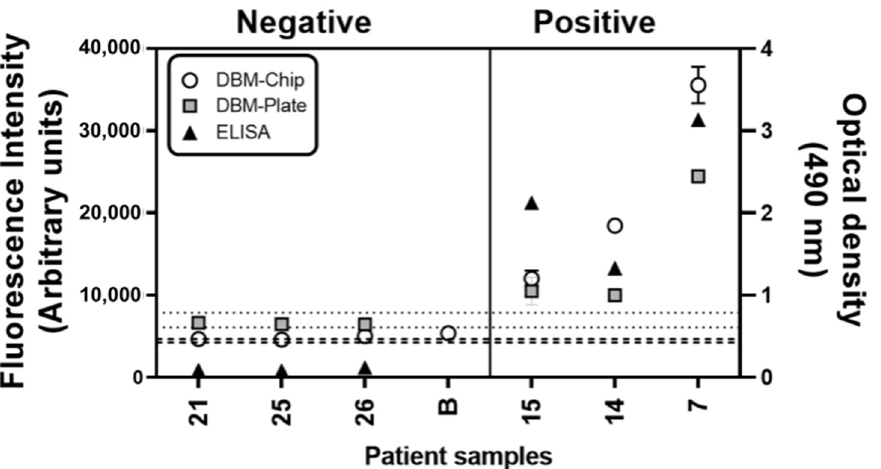
Figure 4. Detection of IgG anti-pigeon antigen antibodies in patients´ sera by Diagnostic Biosensor Method on microfluidic chip and plate. Six patient serum samples were selected (numbers correspond to sample numbers in our lab database), and IgG anti-pigeon antigen antibodies were detected (fluorescence intensity) by the Diagnostic Biosensor Method (DBM) on chip (white dots) and plate (gray squares). They are compared with ELISA optical density (OD) results (black triangles). Range detection limits (average +/ − one standard deviation) are also indicated by the double line, threshold for the chip (—) and plate ( · · · ) were indicated. Data are represented as fluorescence intensity mean ± SD (B: whole blood patient sample).